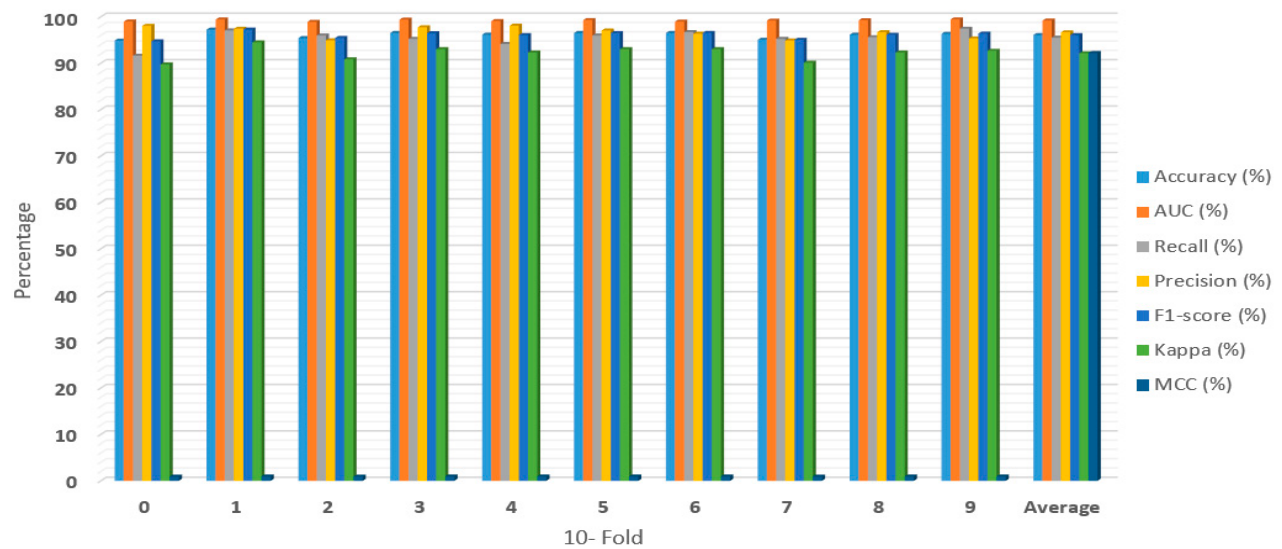
Figure 4. The metrics of the LightGBM model before hyper-parameters tuning.